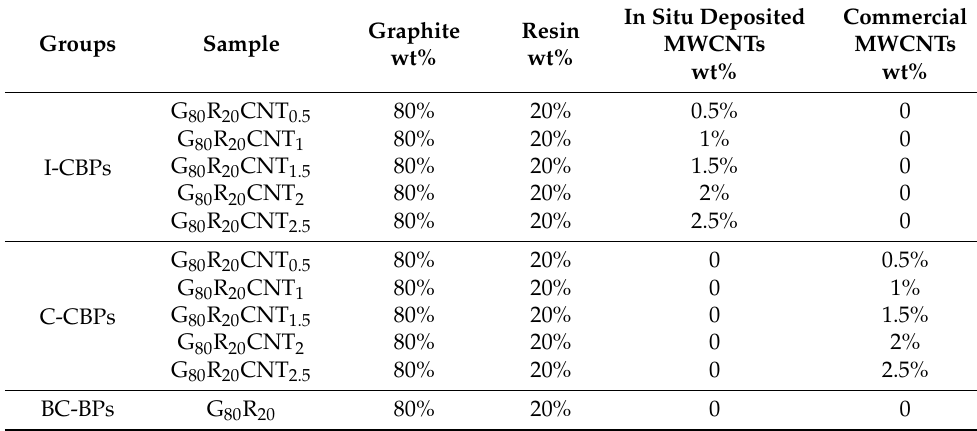
Figure 7. Effect of MWCNTs content and addition method on the performance of BPs: ( A ) in-plane conductivity; ( B ) flexural strength; ( C ) thermal conductivity; ( D ) area-specific resistance; ( E ) gas permeability; ( F ) contact angle. Table 2. Ratio(wt%) of graphite and MWCNTs for different